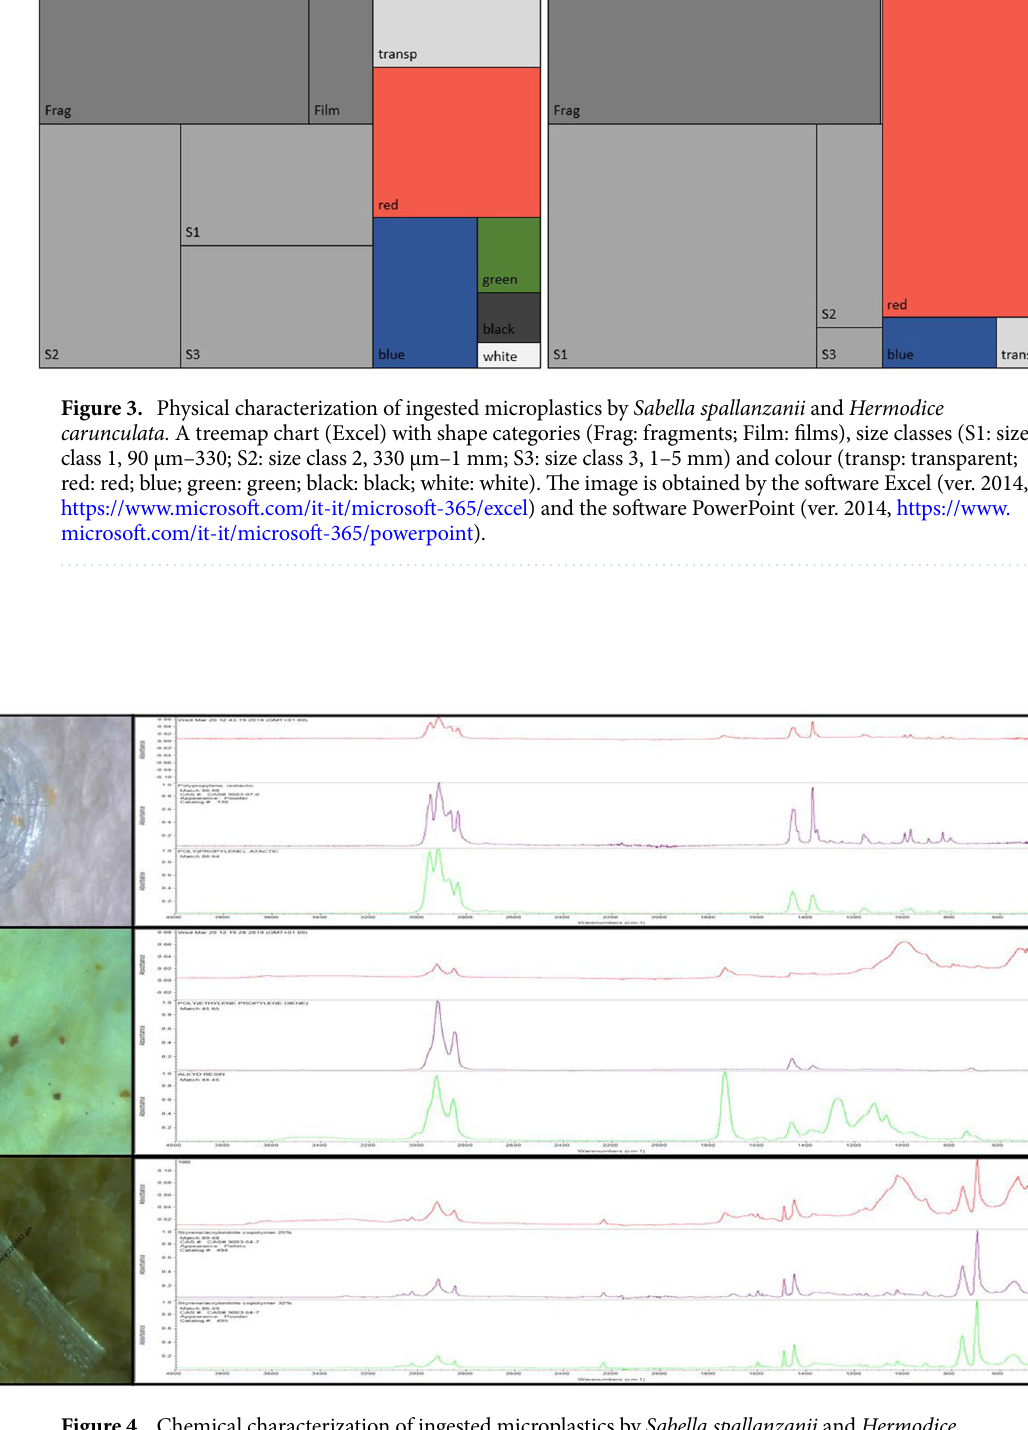
Figure 4. Chemical characterization of ingested microplastics by Sabella spallanzanii and Hermodice carunculata . Picture and infrared spectra of three items are reported. ( a ) polypropylene (PP) fragment found in Sabella spallanzanii . ( b ) mix polyethylene-polypropylene (mix PE-PP) fragment found in Sabella spallanzanii . ( c ) polystyrene (PS) fragment found in Sabella spallanzanii . The pictures are obtained by the software of image for microscope ZEN 2011 SP1 blue edition (6.1.7601) and the FT-IR spectra are obtained by the software OMNIC 9.8.286 (Thermo Fisher Scientific